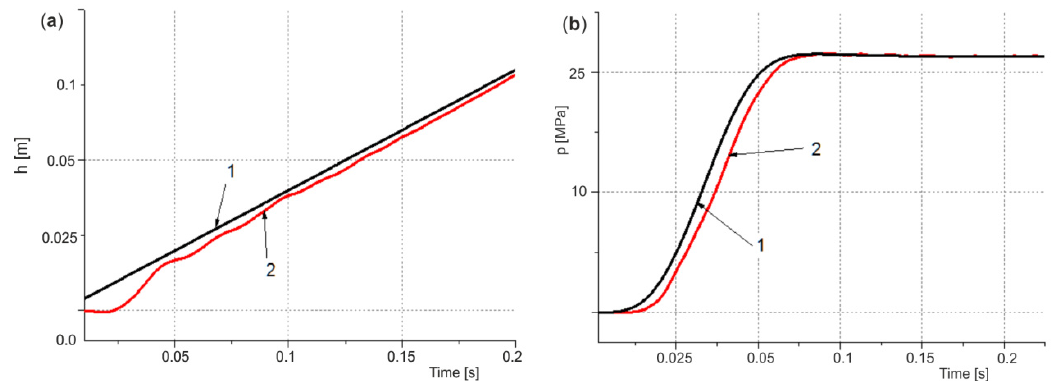
Figure 16. Predictive output signals trajectories for optimal input signals: ( a ) forging height h ( t ), ( b ) load pressure p ( t ): 1—reference signals trajectory, 2—predictive signals trajectory.